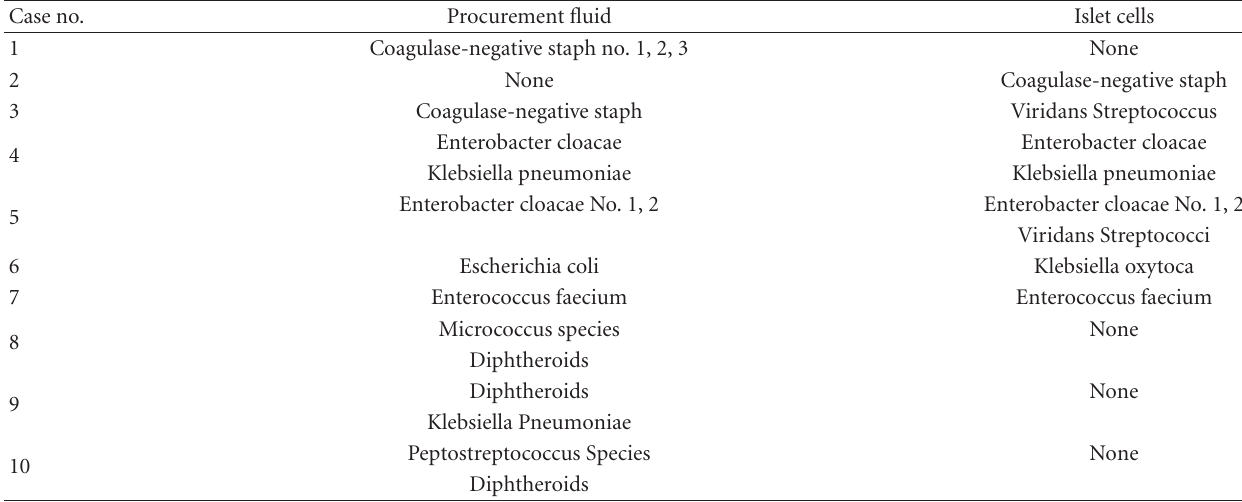
Table 2: Germ identification.